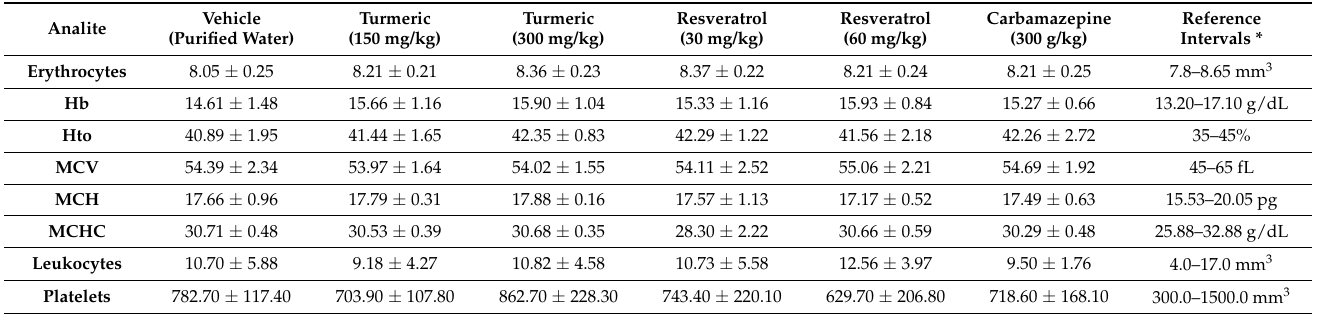
Table 3. Post-status epilepticus complete blood cytometry of rats treated with the vehicle, turmeric, resveratrol, or